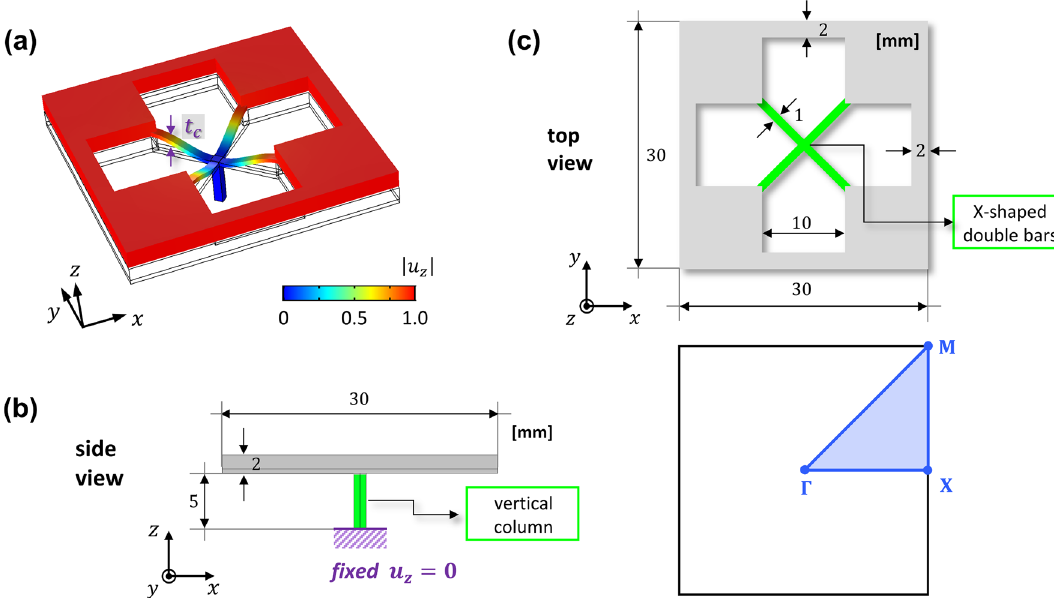
Figure 2. Unit cell with elastic foundation. ( a ) 3D view of the unit cell. ( b ) Geometric information from the side view. ( c ) Geometric information from the top view with the first irreducible Brillouin zone. (unit is in mm).